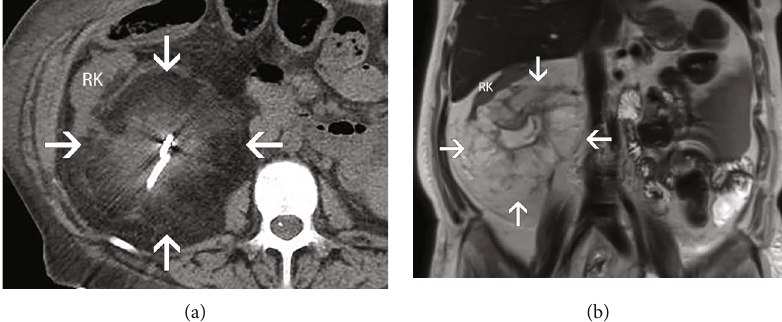
Figure 1: Imaging studies of the right kidney. (a) CT of the abdomen without contrast, axial view. At the level of the mass (outlined by white arrows), the right kidney (RK) is atrophic and there is extensive lipomatous proliferation of the renal sinus fat. The bright linear structure in the middle of the mass is a percutaneous drainage tube. (b) MRI of the abdomen without fat suppression or contrast, coronal T2- weighted image. There is a prominent hyperintense fatty proliferation of the renal sinus fat (outlined by white arrows) displacing the right kidney (RK). There is an associated thin rim of enhancing adjacent renal parenchyma.